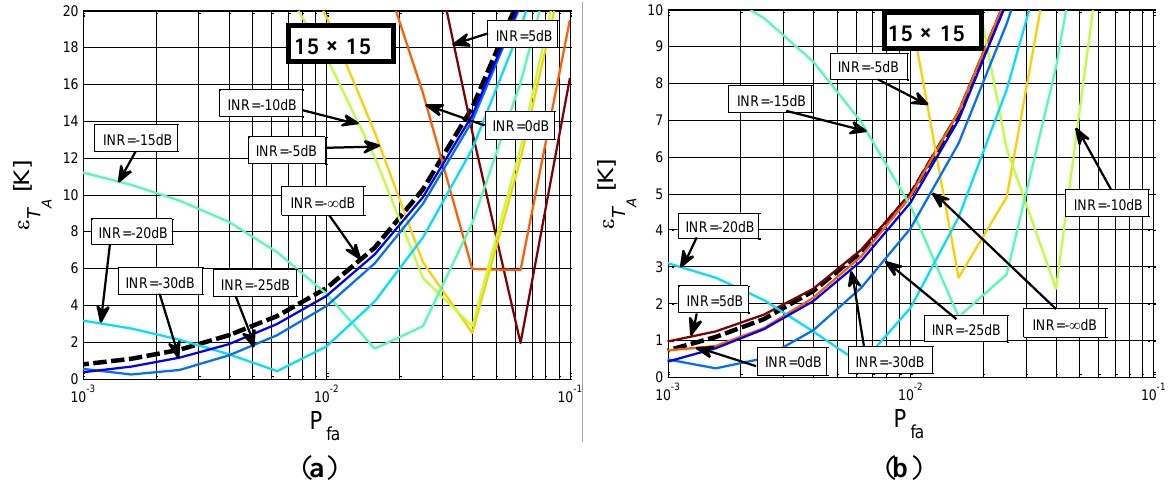
Figure 11. Error obtained by the Smoothing Algorithm in the retrieved T Hann window as smoothing filter. Error is represented in Kelvin ( y -axis), threshold value in P ( x -axis). Colored lines represent RFI contaminated radiometric signals with INR fa value determined by its label. Black dotted line represents a radiometric signal in abscense of RFI. RFI signal is a Pseudo-Random Noise (PRN) interfering signal in 12-a) and an Orthogonal Frequency Division Multiplex (OFDM) interfering signal in 12-b).